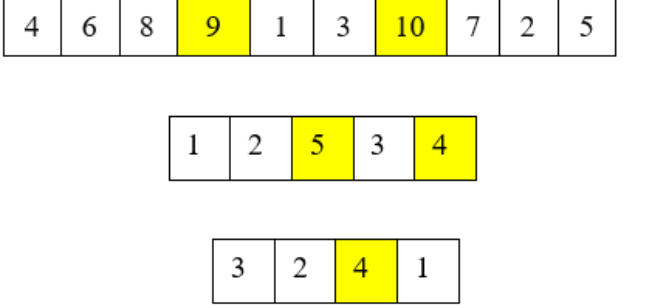
Figure 1. Example of the solution matrix.